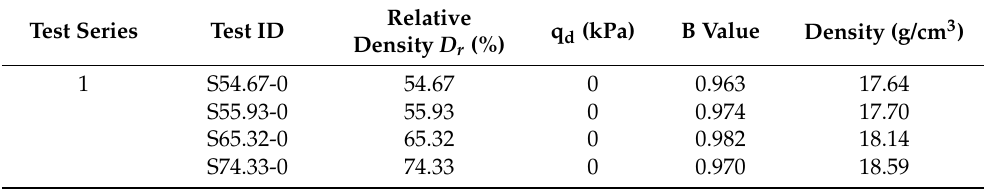
Table 1. Programme of drained monotonic and cyclic